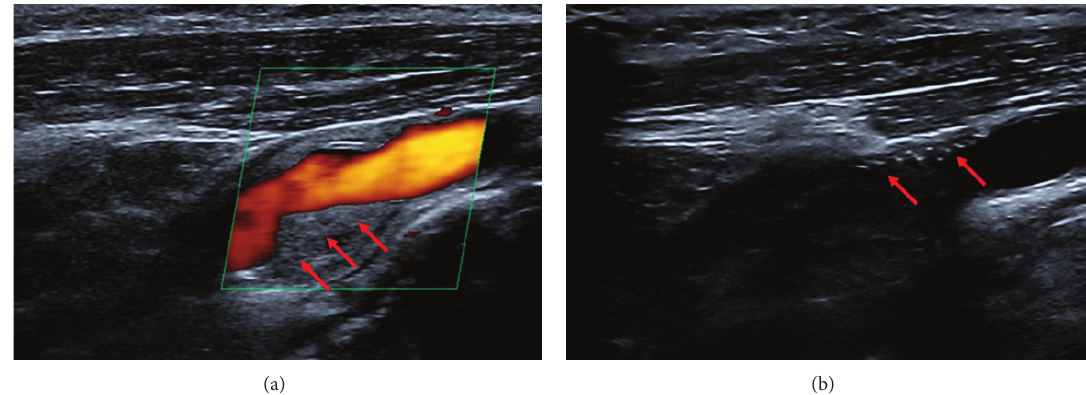
F 1: (a) B-mode and color Doppler ultrasound of right-sided internal carotid artery (ICA) stenosis. Red arrows indicate atherosclerotic ICA plaque. (b) Red arrows indicate the prosthetic patch used in CEA procedure eight years ago.